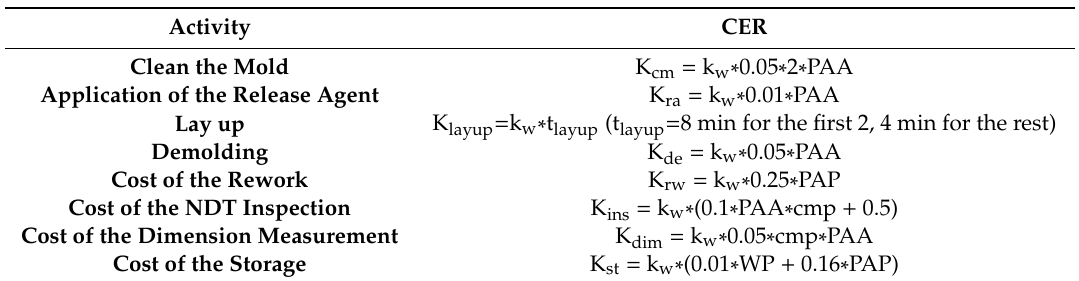
Table 7. CERs for labor cost.